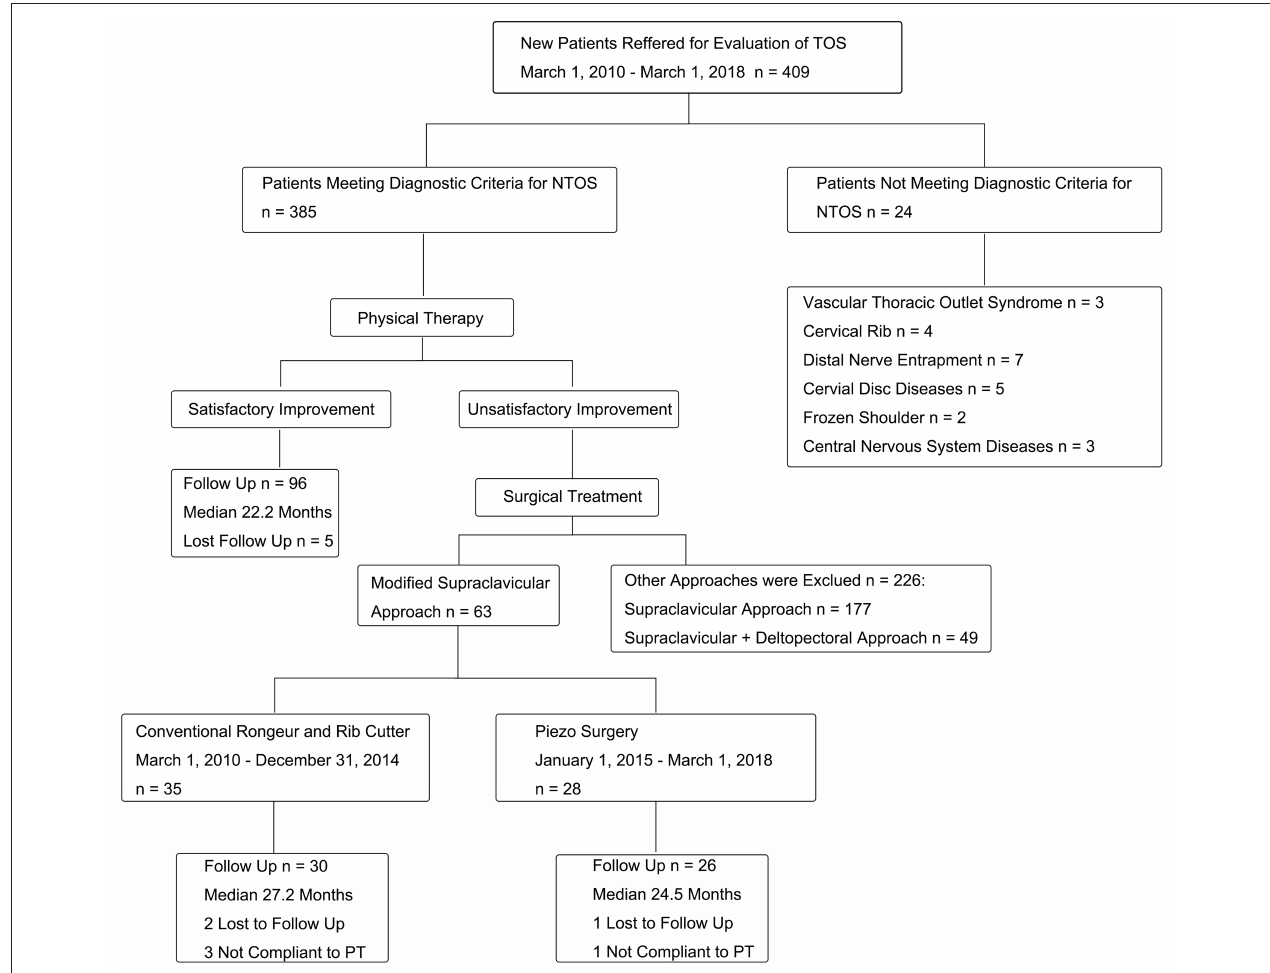
FIGURE 4 | The flow diagram of patient selection of the study. TOS, thoracic outlet syndrome; NTOS, neurogenic thoracic outlet syndrome.